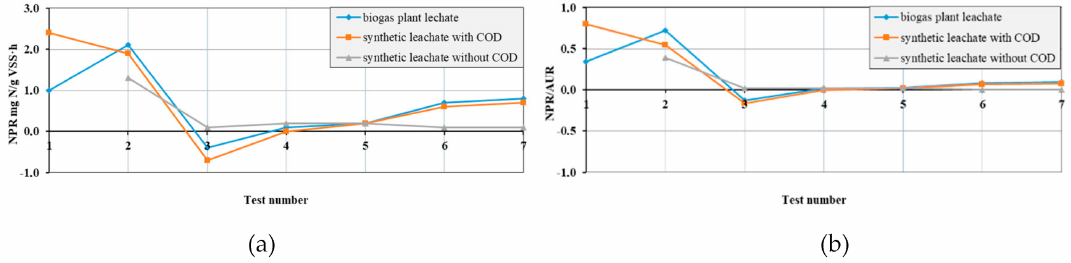
Figure3. Valuesof( a )NPR( b )NPR / AURforanammoxprocesscarriedoutwithLPDaddition,withsynthetic e ffl uents with COD and with synthetic e ffl uents without